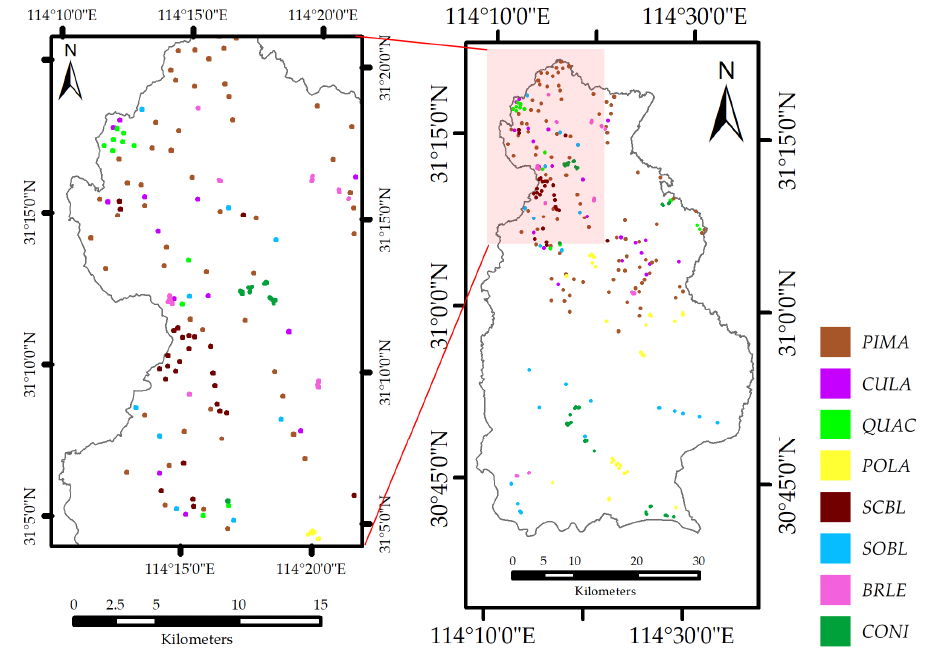
Figure 2. Distribution of reference samples. A scaled sample image ( left ) and the whole reference samples ( right ). Each color represents an individual forest type, including Chinese red pine ( Pinus massoniana , PIMA), China fir ( Cunninghamia lanceolata , CULA), German oak ( Quercus acutissima , QUAC), Chinese white poplar ( Populus lasiocarpa , POLA), mixed Sclerophyllous Broad-Leaved forest (SCBL), mixed Soft Broad-Leaved forest (SOBL), mixed Broad-Leaved forest (BRLE) and mixed Coniferous forest (CONI).